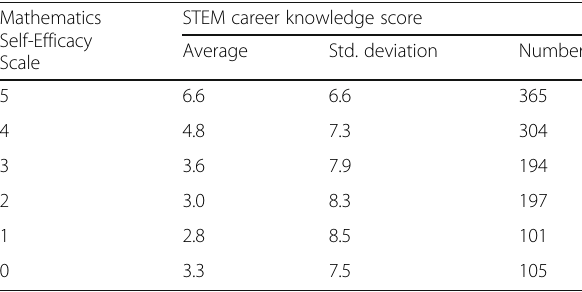
Table 5 The correlation between mathematics self-efficacy (MSE) on STEM career knowledge (SCK) scores Mathematics STEM career knowledge Self-Efficacy Scale